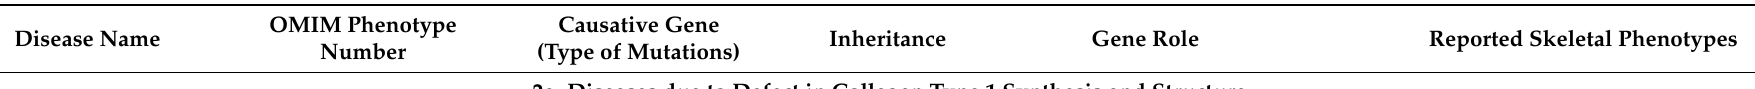
Table 2. Congenital metabolic bone disorders due to altered extracellular matrix proteins (disorders of collagen type 1 synthesis and